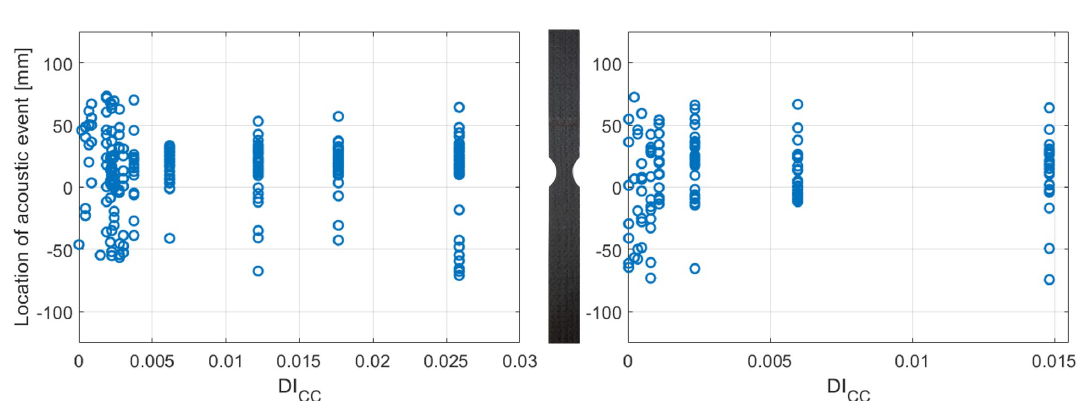
Figure 8. Location of the acoustic events vs. damage index DI CC . Left : 0/90 test specimen. Right : +45/ − 45 test specimen.